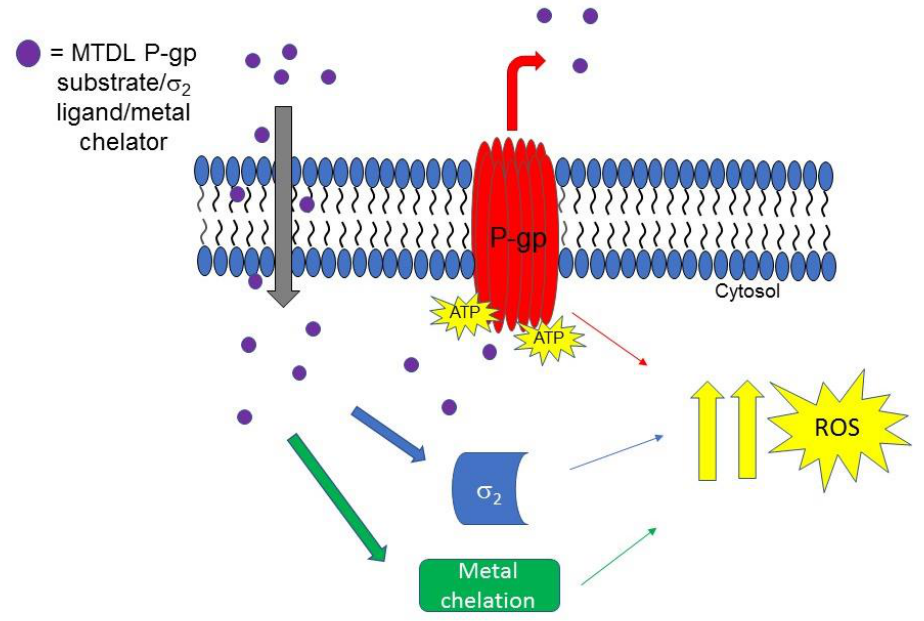
Figure 6. MTDL acting upon interaction with σ 2 and P-gp proteins and metal chelation. The MTDL, that is a P-gp substrate, upon efflux, activates the futile ATP cycle that leads to ROS increase. The effect is synergized by interaction with σ 2 receptor and metal ions chelation.